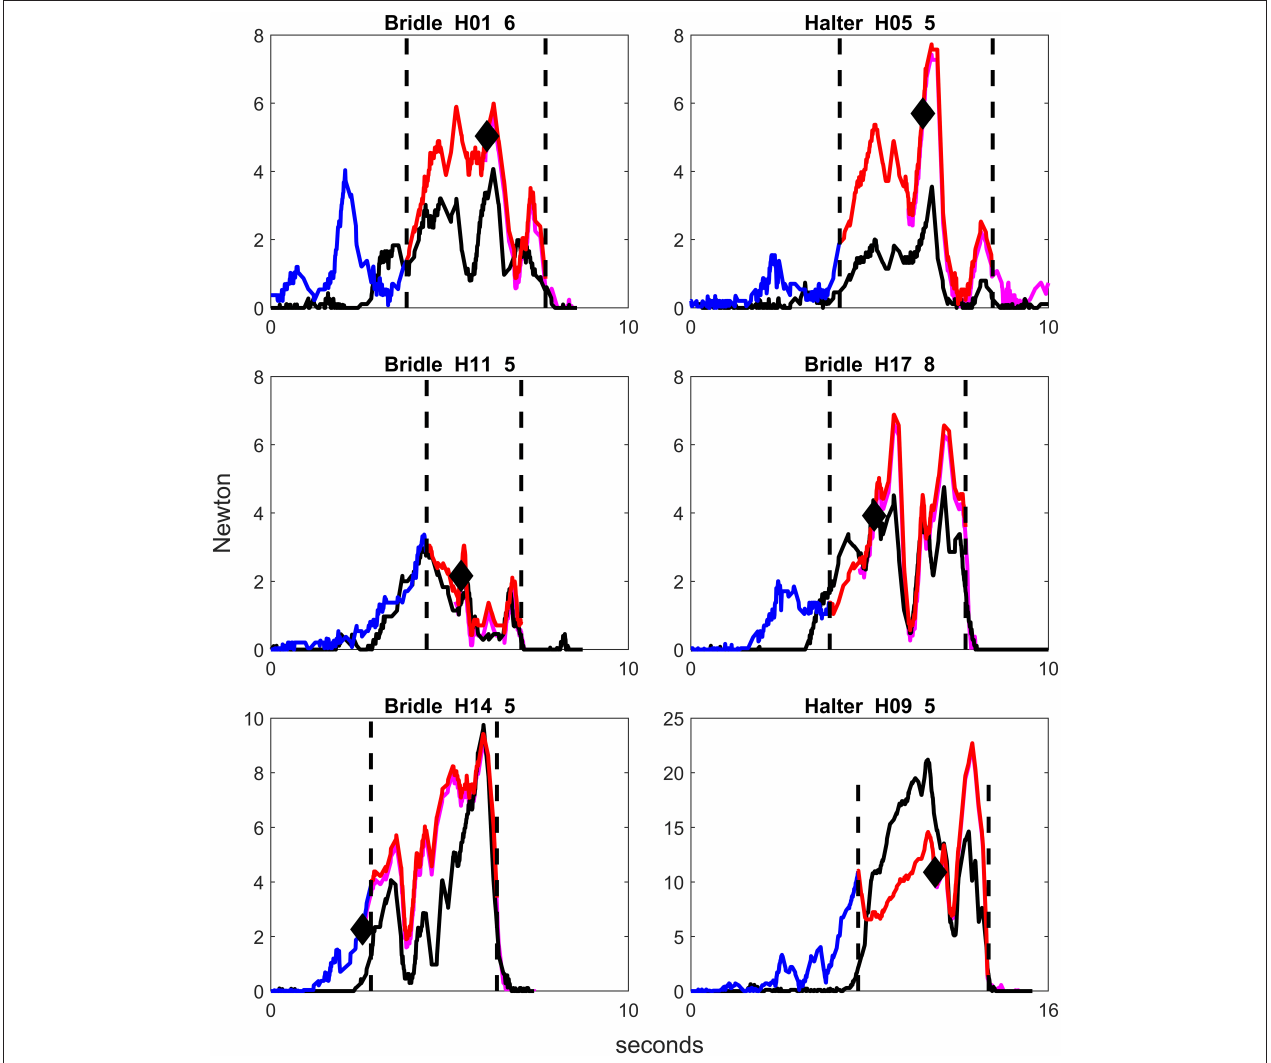
FIGURE 4 | Examples of graphs of rein tension signals using bridle or halter in different horses, from repetitions where the handler applied rein tension for two steps and with no other behavioral response than backing. Blue color on the rein tension curve illustrates the phase picking up the reins, red color illustrates the rein tension signal, and purple illustrates the horse stepping back. Only the right rein is colored. The first vertical dotted line demonstrates the onset of the rein tension signal and the second vertical dotted line displays the lowering of the handler’s hands, i.e., release of the rein tension signal. The black diamond signifies the onset of backing. The decrease in magnitude of rein tension shown after the onset of backing demonstrates the release of rein tension for the first step back. H = Horse, first number is horse number, second number is repetition number. Note that the scale on both the x-axis and the y-axis differs slightly between graphs.